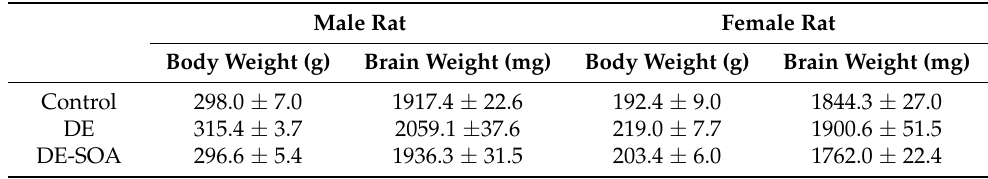
Table 1. Body weight and brain weight of male and female offspring rats.